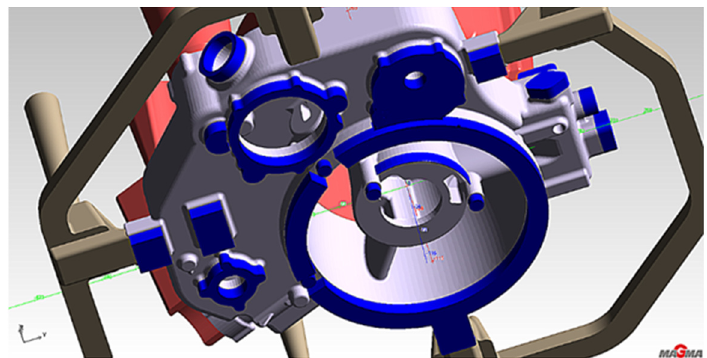
Figure 18. Stage 5 Cast iron chillers with increased thickness.